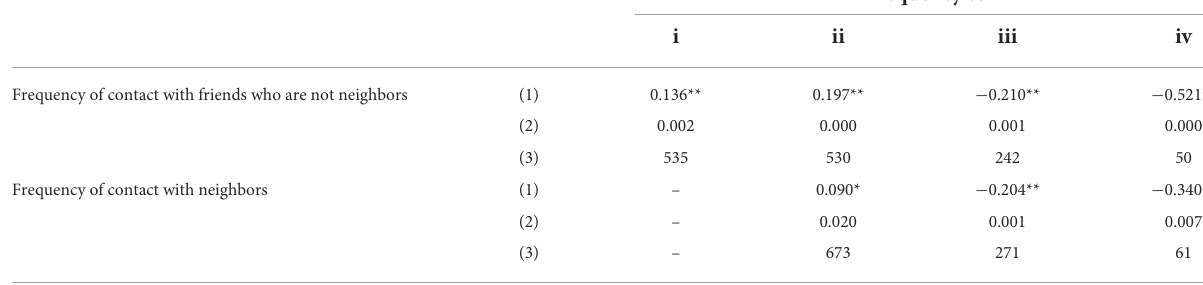
TABLE 8 Correlational significance between the groups of variables (II).